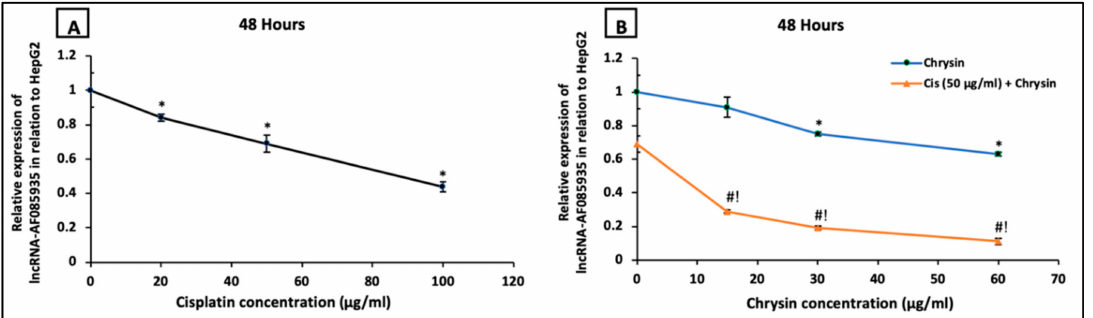
Figure 7. Impact of 48 h treatment with ( A ) cisplatin (Cis; 20, 50, 100 µ g / mL), ( B ) chrysin (15, 30, 60 µ g / mL) and combination of chrysin (15, 30, 60 µ g / mL) with Cis 50 µ g / mL on lncRNA-AF085935 expression in HepG2 cells. Results are presented as Mean ± SD. * p < 0.05 versus the control untreated cells. # p < 0.05 versus the same dose of chrysin. ! p < 0.05 versus Cis 50 µ g /